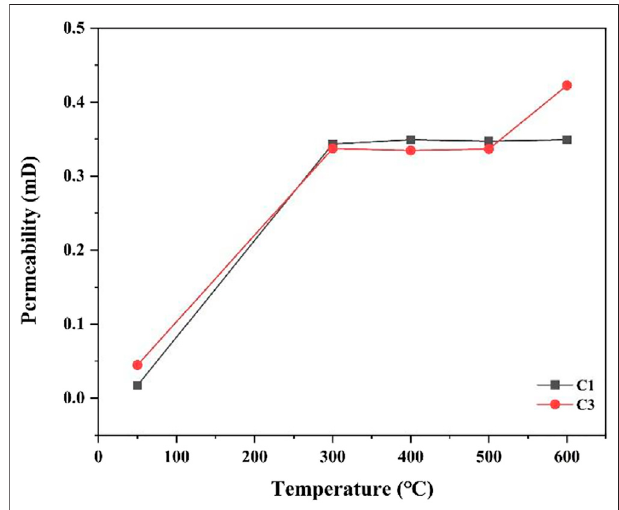
FIGURE 4 | Tensile strength of the cement paste cured at different temperatures.